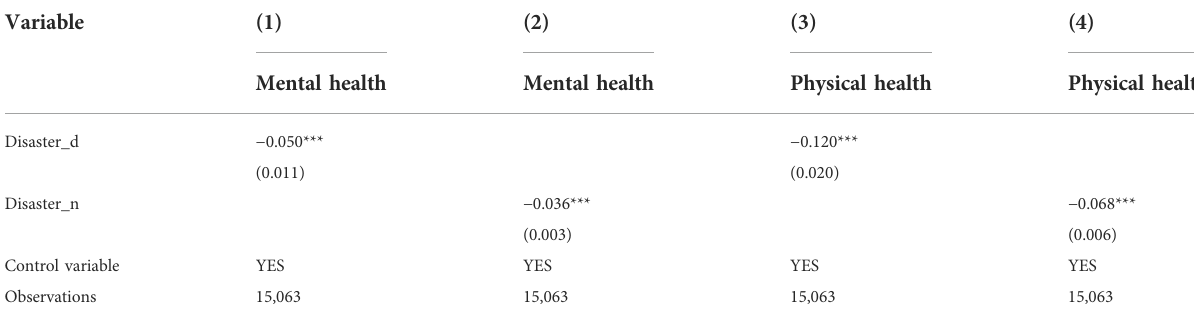
TABLE 9 Impact of natural disasters on individuals ’ physical and mental